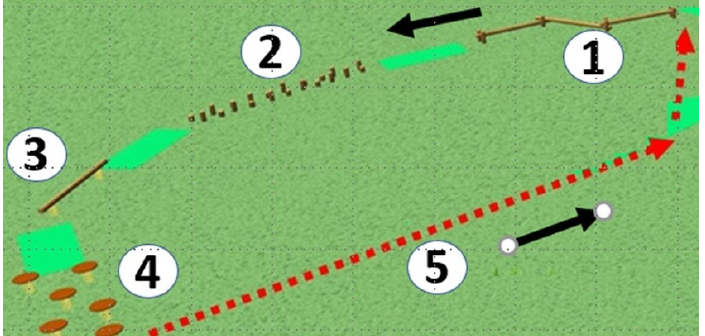
Figure 3. Motor circuit in the balance area. The children started the balance path from point 1